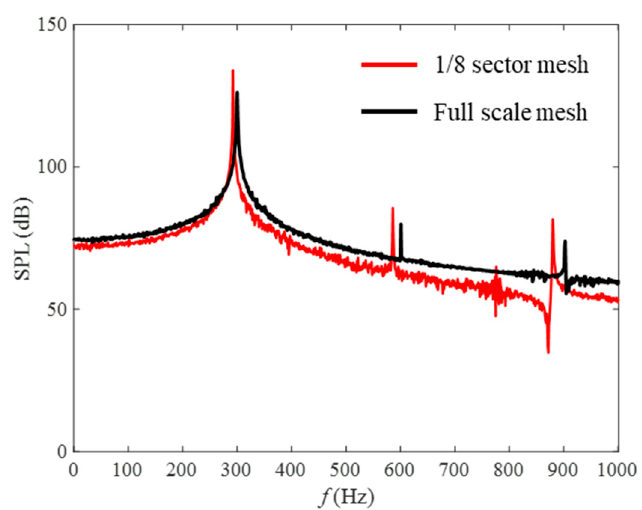
Figure A1. Radical profiles of axial velocity comparison.